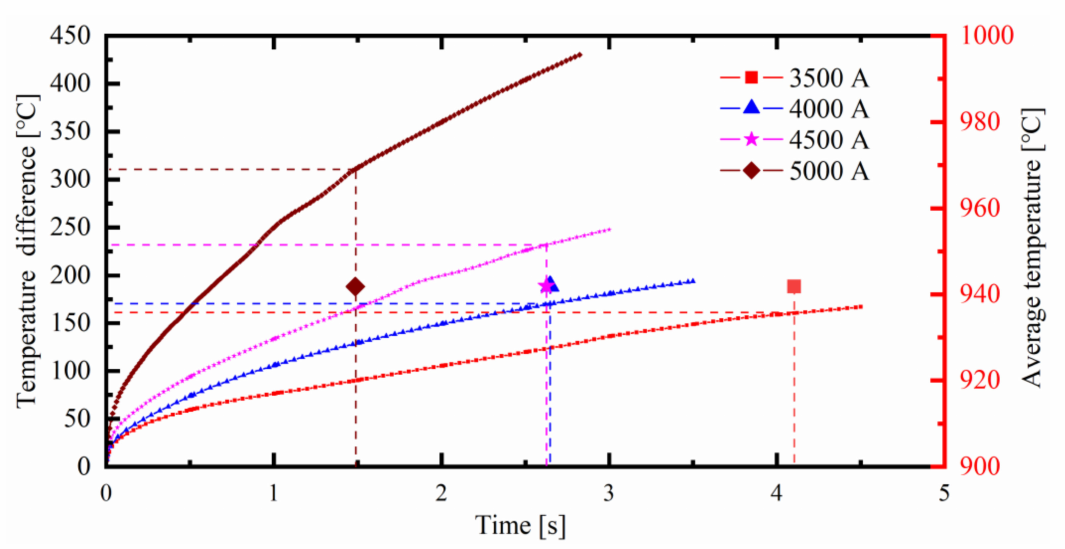
Figure 18. The temperature difference and average temperature 942 ± 0.1 ◦ C with different input